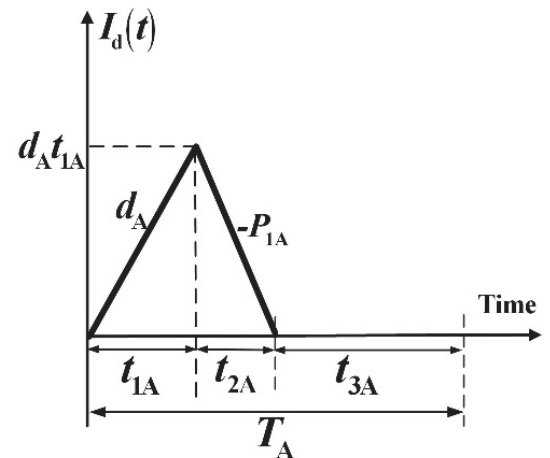
Fig. 1. Inventory level of finished products in any given cycle of the proposed EMQ-based system (in bold lines) compared to that in the classic EMQ model (in thin lines)